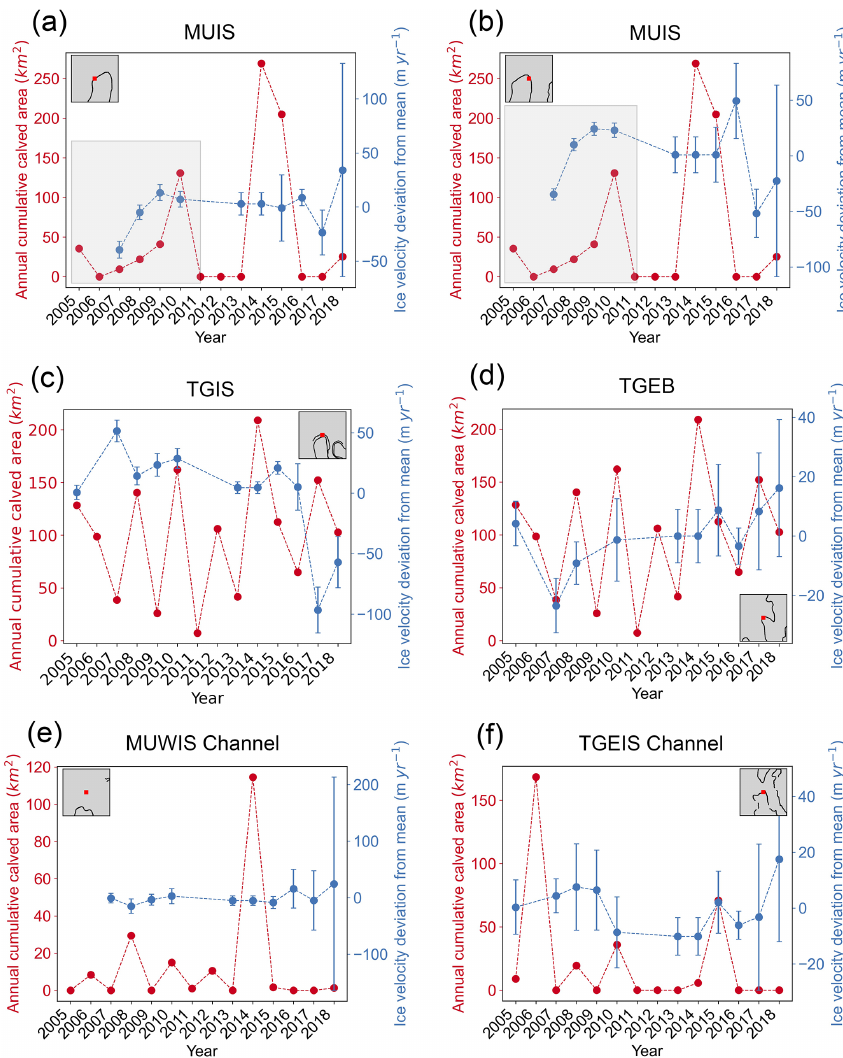
Figure 13. The zero mean ice velocity time series at each grounding zone (red box in the grey inset map) derived from MEaSUREs (2005– 2016) (Mouginot et al., 2017a, b) and ITS_LIVE (2017–2018) (Gardner et al., 2018, 2019) annual ice velocities, and the annual cumulative iceberg calved area at the ice shelf front (Qi et al.,